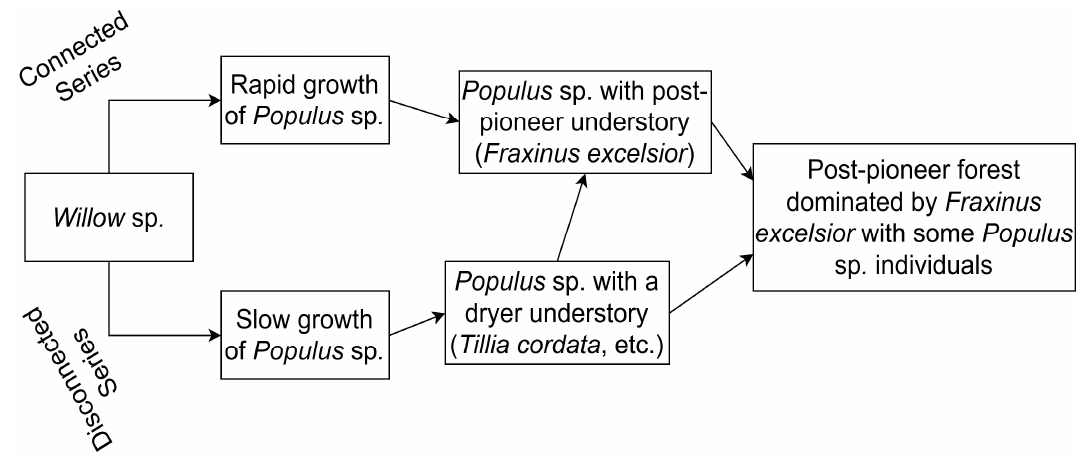
Figure 2. Trajectories of the riparian forest based on surveys conducted by the French National Forestry Office. They distinguish an initial colonization and growing phase (by Salix sp. and Populus nigra ) from later successional stages that are more mature, where the tree width of Populus nigra increases and post-pioneer species start appearing in the understory or overtake as the predominant species.